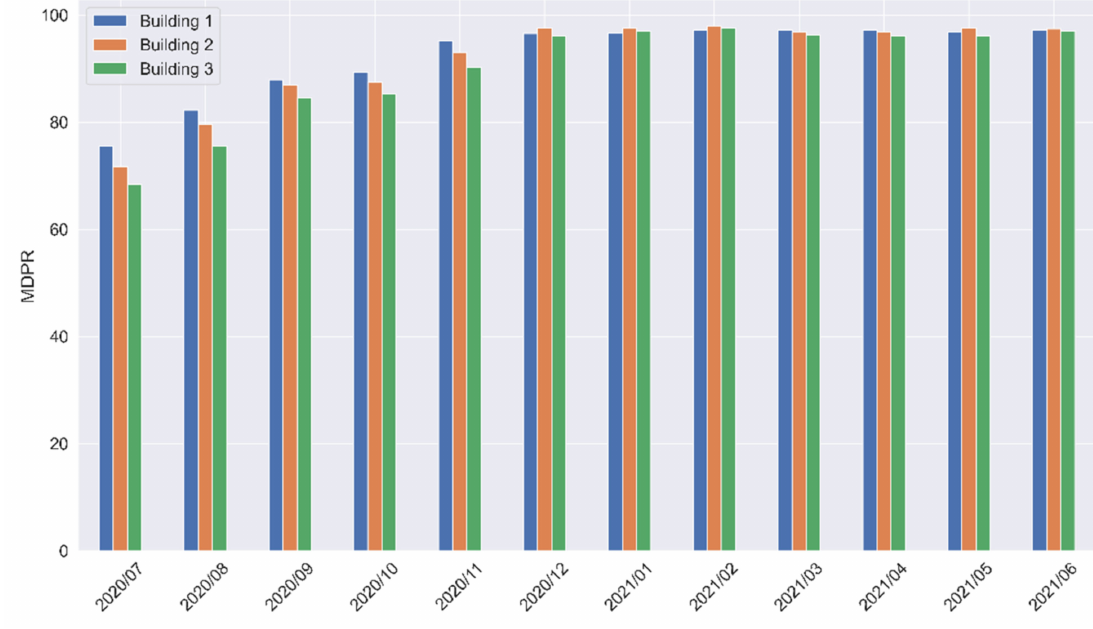
Figure 8. Monthly value of MDPR per